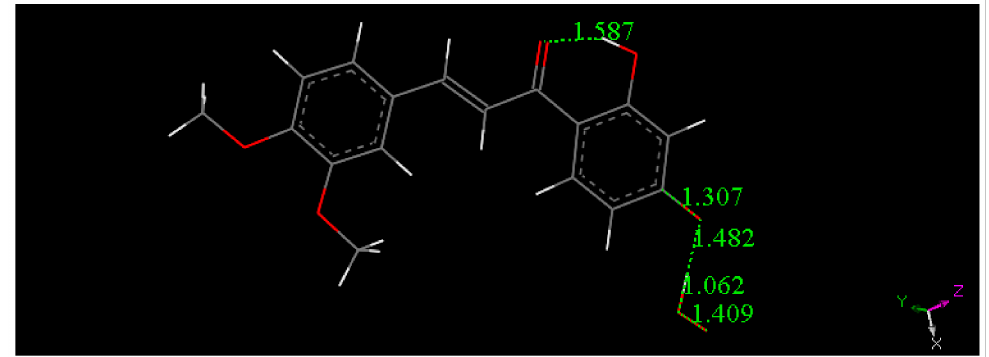
Figure 12. Resulting geometry minimization for H(hydroxyl) in position 4 (cid:48) of DHDM chalcone, approached by superoxide (initially separated by van der Waals distance 2.6 Å). Distances shown in this picture are minimized in water solvent including dispersion term Grimme. The 4 (cid:48) -hydroxyl H atom is not captured by superoxide, O(superoxide)- H distance is 1.553 Å.